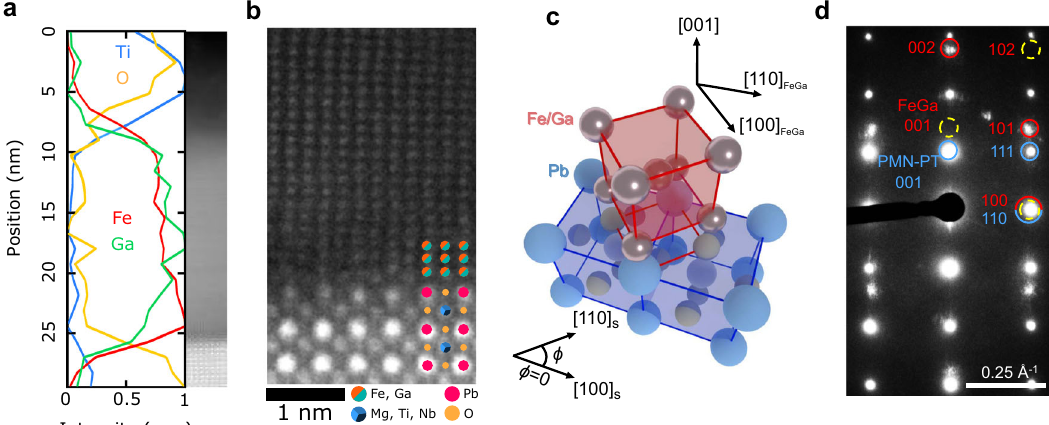
Fig. 1 Epitaxial stabilization of A2 Fe 1 − x Ga x on (001) PMN-PT. a Electron energy loss spectroscopy (EELS) of the PMN-PT substrate and Fe 1 − x Ga x fi lm as a function of fi lm thickness, showing abrupt concentration edges and a nominal thickness of ~15 nm for the Fe 1 − x Ga x fi lm. Ti signal comes from the capping layer to prevent oxidation. b High-angle annular dark- fi eld scanning transmission electron micrographs (HAADF-STEM) along the PMN-PT [100] / Fe 1 − x Ga x [110] zone axis, showing the single crystalline, epitaxial relationship along the [100] s substrate direction. c Diagram showing the epitaxial relationship of PMN-PT (blue) and Fe 1 − x Ga x (red) normal to the interface ([001] direction); crystallographic directions of the fi lm and the substrate are shown. d Interfacial selected area electron diffraction (SAED) con fi rming that the Fe 1 − x Ga x thin fi lm is in the disordered A2 phase due to the absence of superlattice peaks which would appear in the ordered D0 3 phase. Bragg peaks of the Fe 1- x Ga x (red) only appear when the sum of reciprocal lattice indices is even (missing peaks shown as yellow dashed circles), indicating a solid solution BCC crystal structure. Parts ( a ), ( b ), and ( d ) are collected from a representative 30% Ga sample, full diffraction data are shown in Sup. Fig.